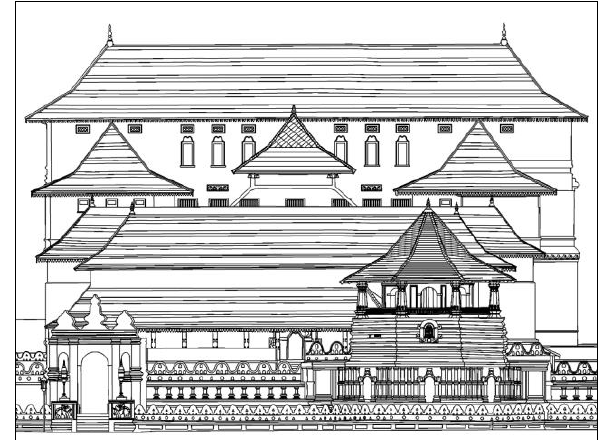
Fig. 6. Moonstone. Shaded relief and textured 3D-Model Fig. 7. Elevation of the west façade